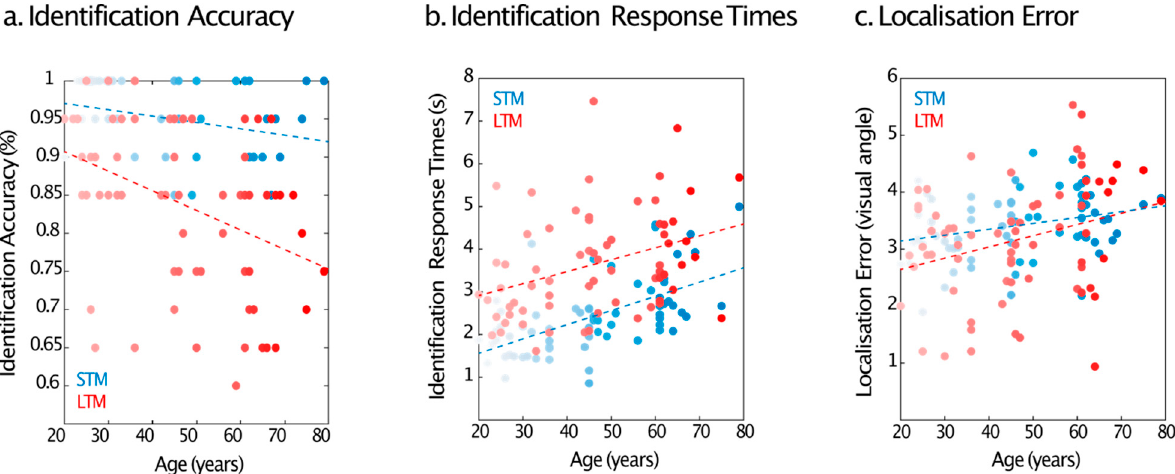
Figure 5. Variation of performance on both STM and LTM retrieval tasks across age in Experiment 2. Dots represent individual participants’ means ( a ) Identification Accuracy. Overall, ageing impaired performance on both memory tasks, with the worst performance in the LTM trials. ( b ) Identification Response Times. Overall, participants were slower in the LTM task and both short- and long-term memory trials were influenced by ageing. ( c ) Localisation Error. Performance was significantly less accurate for older than younger adults in identifying the location of the target object. Dots represent individual participant’s means.